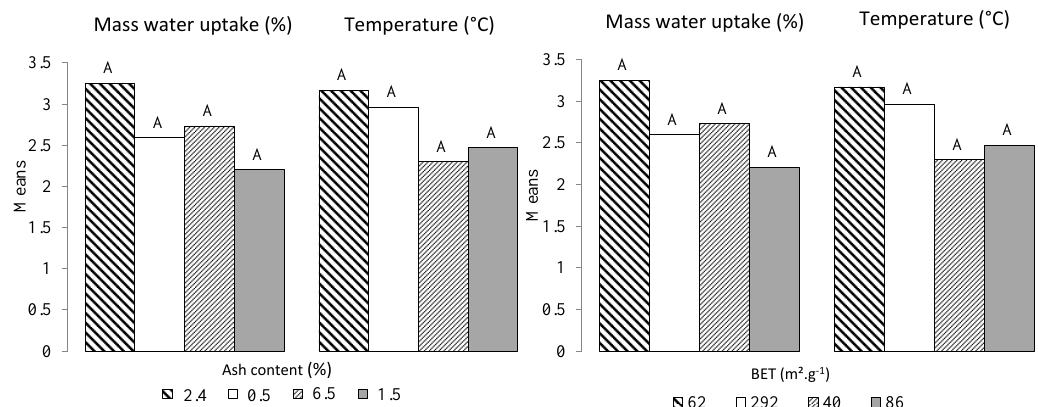
Figure 3. Classification by Tukey’s test for water sorption ( W ) and temperature ( T ) averages versus BET and ash content. The means with the same letter were not significantly different at 5% (α = 0.05).